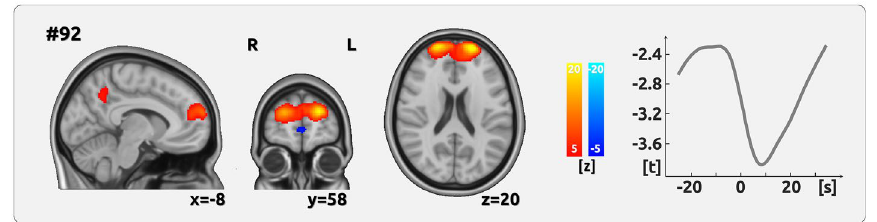
Figure 2. Encoding of pain amplitude for CM. The figure shows the network whose time course exhibited a significant negative relationship with the time course of pain intensity (AMP). The cortical maps on the left side show the spatial characteristics of the networks and are the result of the Melodic ICA. Z-scores were also determined by Melodic and depict the contribution of each voxel to the respective network. The right side exhibits the analysis of the component time courses. The time courses, which are the output from the dual regression, were then related to the time course of pain ratings using LMEs. The graph shows the results of the shifts between − 25 and 35 s in relation to the current rating (0 s). The network essentially comprises the prefrontal cortex.